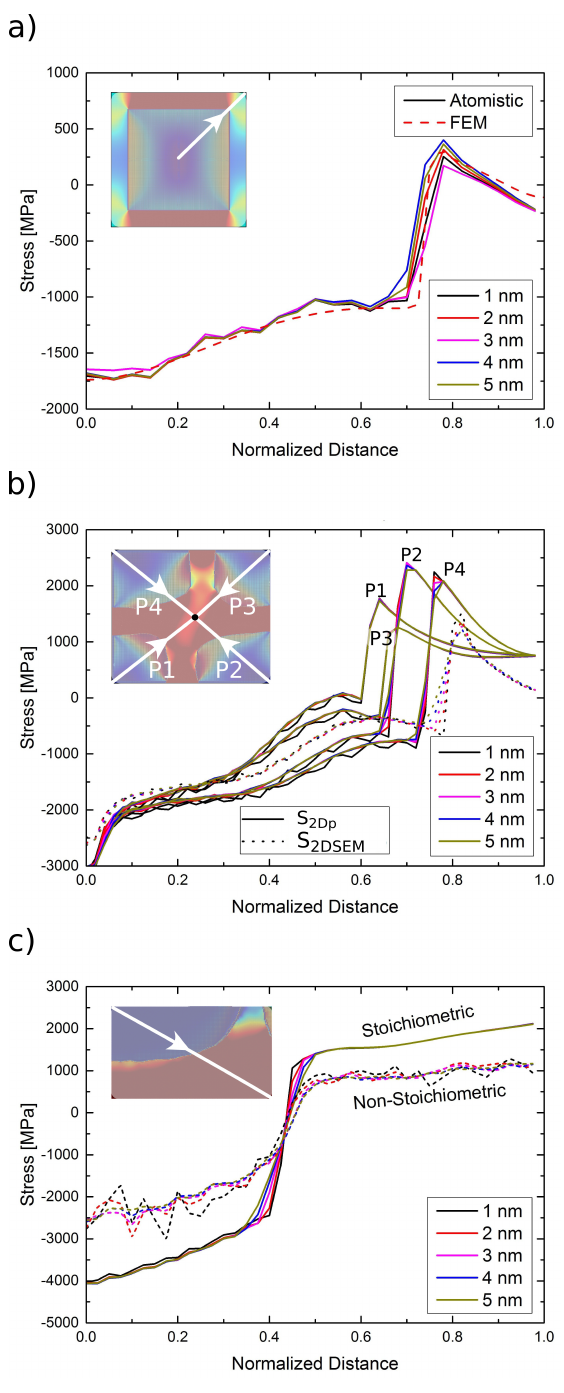
Figure 4. Stress profile (stress component σ xx ) along an internal face diagonal in the different samples. The path used in each sample is marked in white in the corresponding sample (see inset). ( a ) Atomistic sample S cub and FEM sample S FE ; ( b ) Atomistic samples S 2 Dp and S 2 DSEM ; four different paths are used in sample S 2 DSEM . Since the corresponding paths are identical in sample S 2 Dp , only one path is shown. ( c ) APT-informed stoichiometric sample S APT , stoi and non-stoichiometric sample S APT , non − stoi . For all atomistic samples, stress profiles were obtained by extracting atoms inside a cylinder along the path considered. Results for five different cylinder radii ( r = 1,2,3,4,5 nm) are